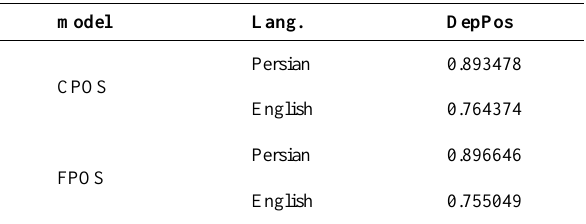
Table 6. Dependency parsing results with gold.